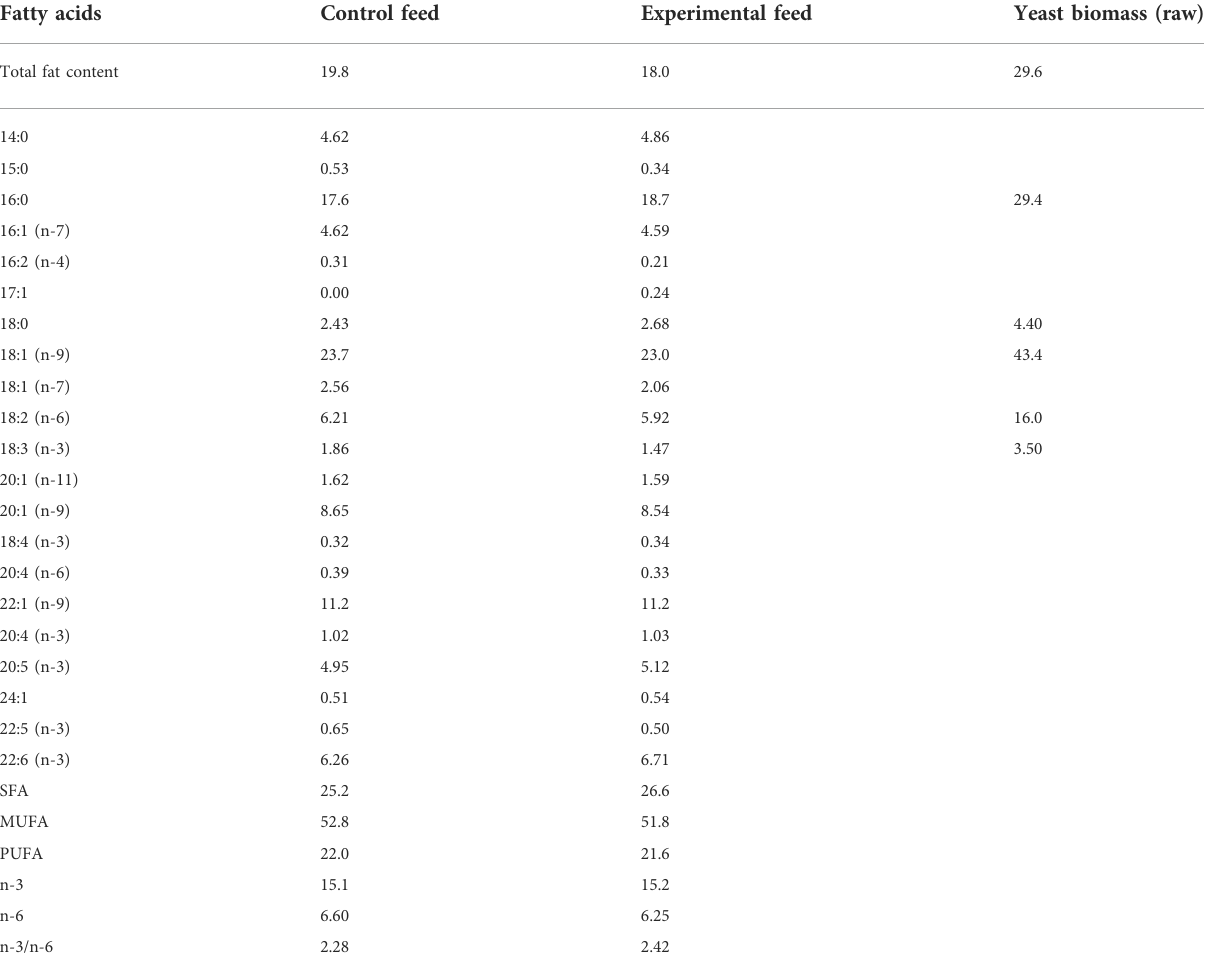
TABLE 2 Total fat content (g kg − 1 wet weight), fatty acid composition (% of total identi fi ed FA) of the two fi sh feeds (duplicate analyses), and yeast biomass separately. Fatty acids Control feed Experimental feed Yeast biomass